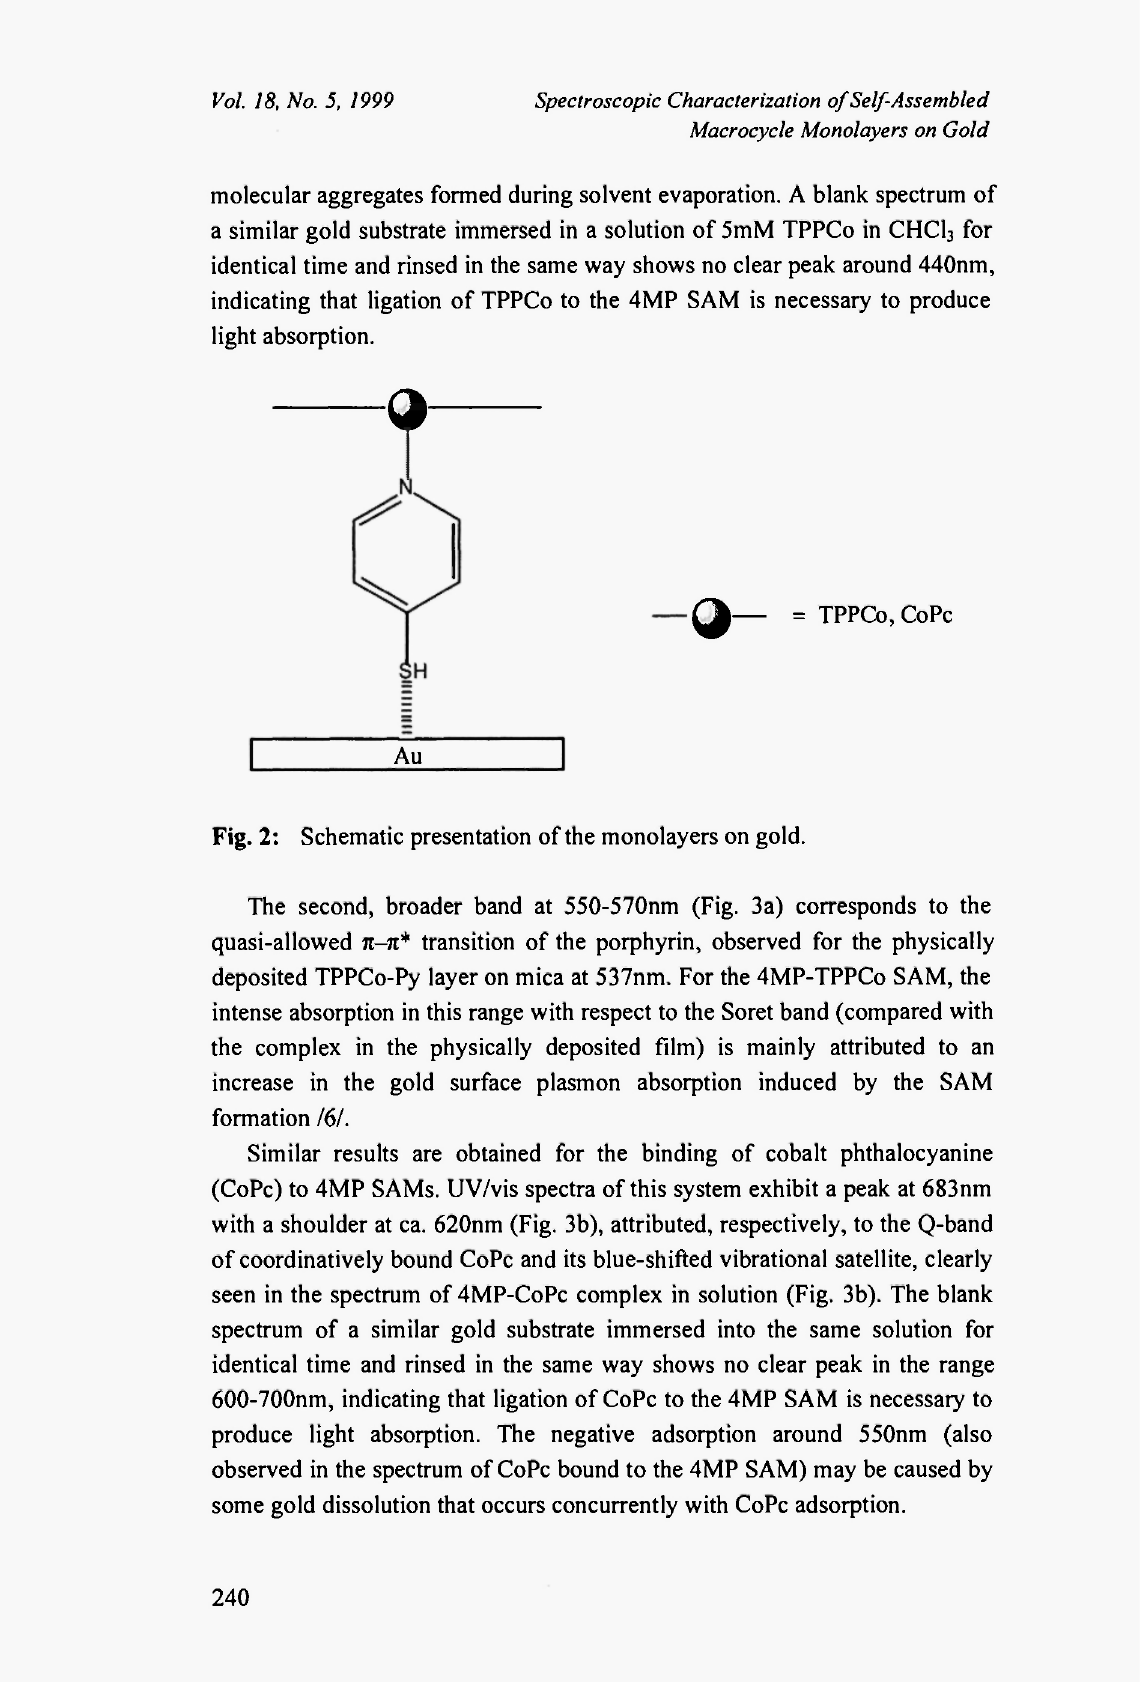
Fig. 2: Schematic presentation of the monolayers on gold. The second, broader band at 550-570nm (Fig. 3a) corresponds to the quasi-allowed π-π* transition of the porphyrin, observed for the physically deposited TPPCo-Py layer on mica at 537nm. For the 4MP-TPPCo SAM, the intense absorption in this range with respect to the Soret band (compared with the complex in the physically deposited film) is mainly attributed to an increase in the gold surface plasmon absorption induced by the SAM formation 161. Similar results are obtained for the binding of cobalt phthalocyanine (CoPc) to 4MP SAMs. UV/vis spectra of this system exhibit a peak at 683nm with a shoulder at ca. 620nm (Fig. 3b), attributed, respectively, to the Q-band of coordinatively bound CoPc and its blue-shifted vibrational satellite, clearly seen in the spectrum of 4MP-CoPc complex in solution (Fig. 3b). The blank spectrum of a similar gold substrate immersed into the same solution for identical time and rinsed in the same way shows no clear peak in the range 600-700nm, indicating that ligation of CoPc to the 4MP SAM is necessary to produce light absorption. The negative adsorption around 550nm (also observed in the spectrum of CoPc bound to the 4MP SAM) may be caused by some gold dissolution that occurs concurrently with CoPc